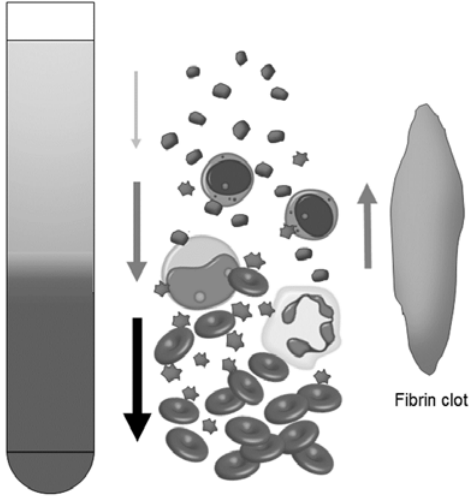
Figure 7. Scheme of migration of major blood components during centrifugation.